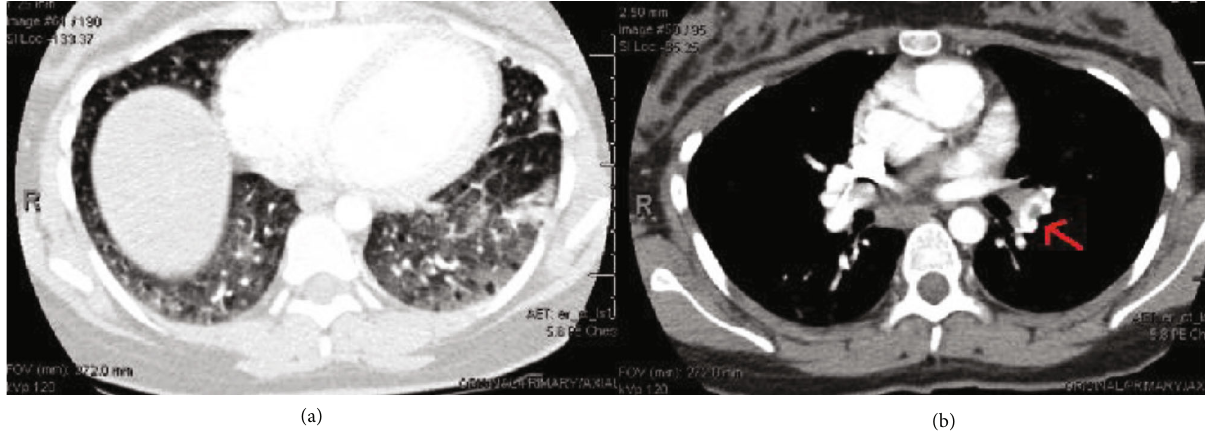
Figure 3: Computed tomography of the chest demonstrating di ff use ground-glass opacities (a) throughout both lungs, which can be seen with COVID-19 pneumonia. Acute pulmonary emboli (b) identi fi ed in segmental branches of lingula and left inferior lobar pulmonary artery extending into segmental branches of left lower lobe, with fi lling defect noted by red